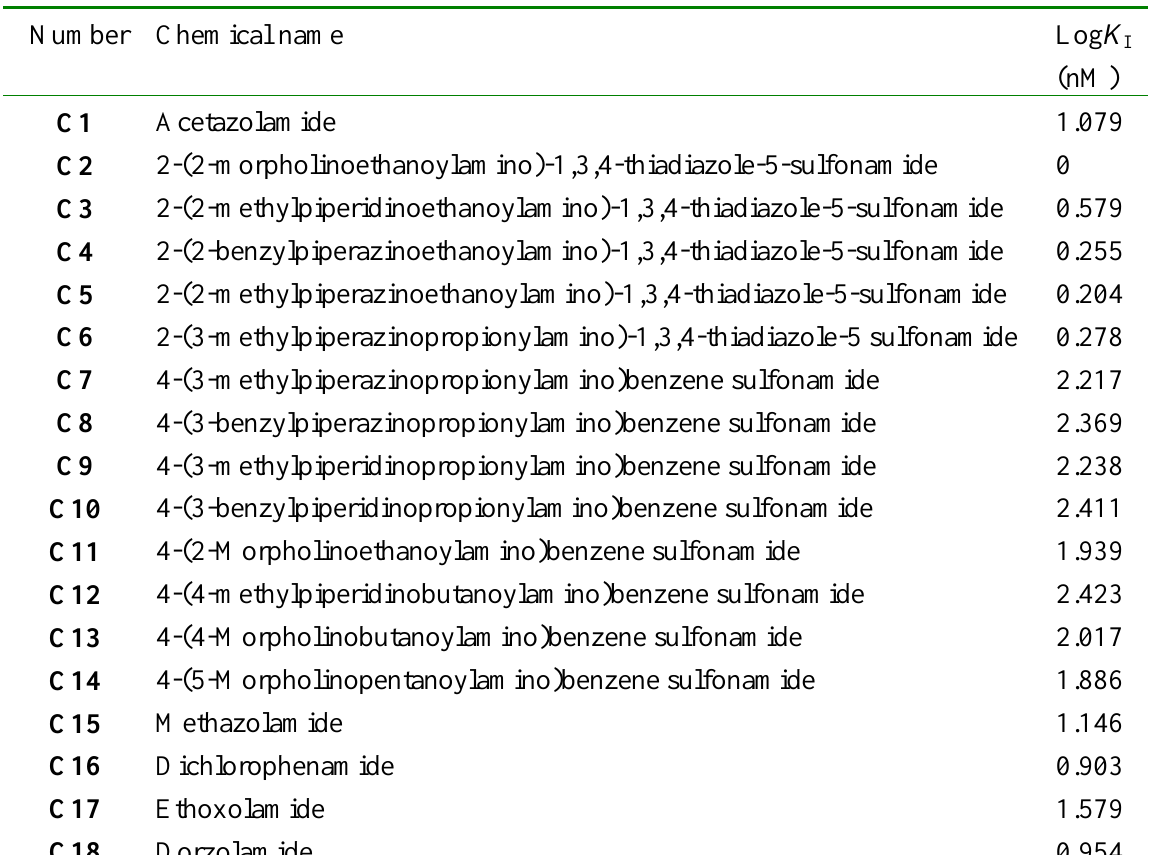
Table 1. The list of chemical name of the compounds studied and their observed Log K